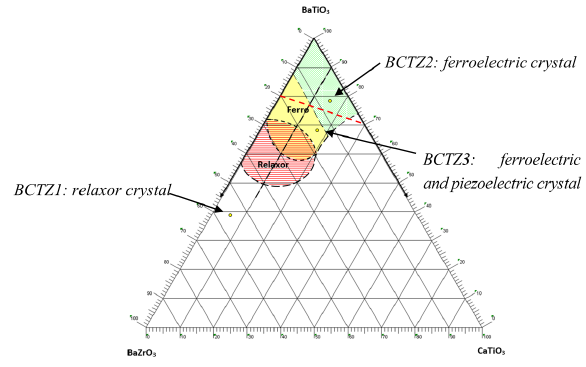
Figure 10. Molar pseudo-ternary phase diagram BaTiO 3 -BaZrO 3 -CaTiO 3 three different crystals compositions (yellow discs) are inserted in the relaxor-ferroelectric zones described by Ravez et al. [33]. Dielectric behaviors of the crystals are in accordance with ceramics of same compositions [5,33]. Red dashed line corresponds to the (1 − x )BaTi 0.8 Zr 0.2 O 3 - x Ba 0.7 Ca 0.3 TiO 3 promising piezoelectric compositions above mentioned.